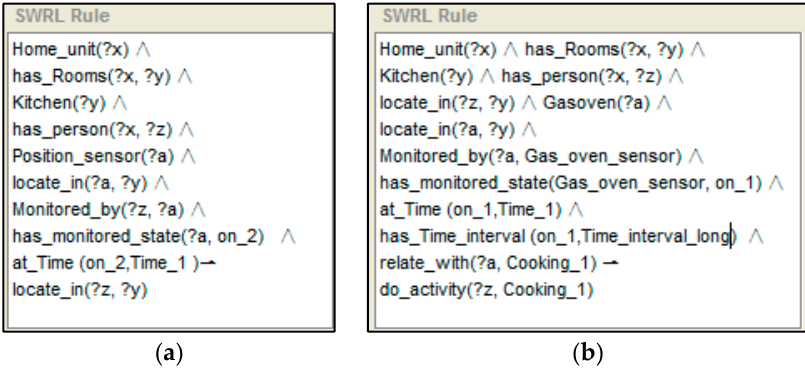
Figure 10. An example of person activity recognition reasoning based on a rule (cooking, in this case). The first one ( a ) shows the recognition of the position of a person. The second one ( b ) shows the recognition of the activity.